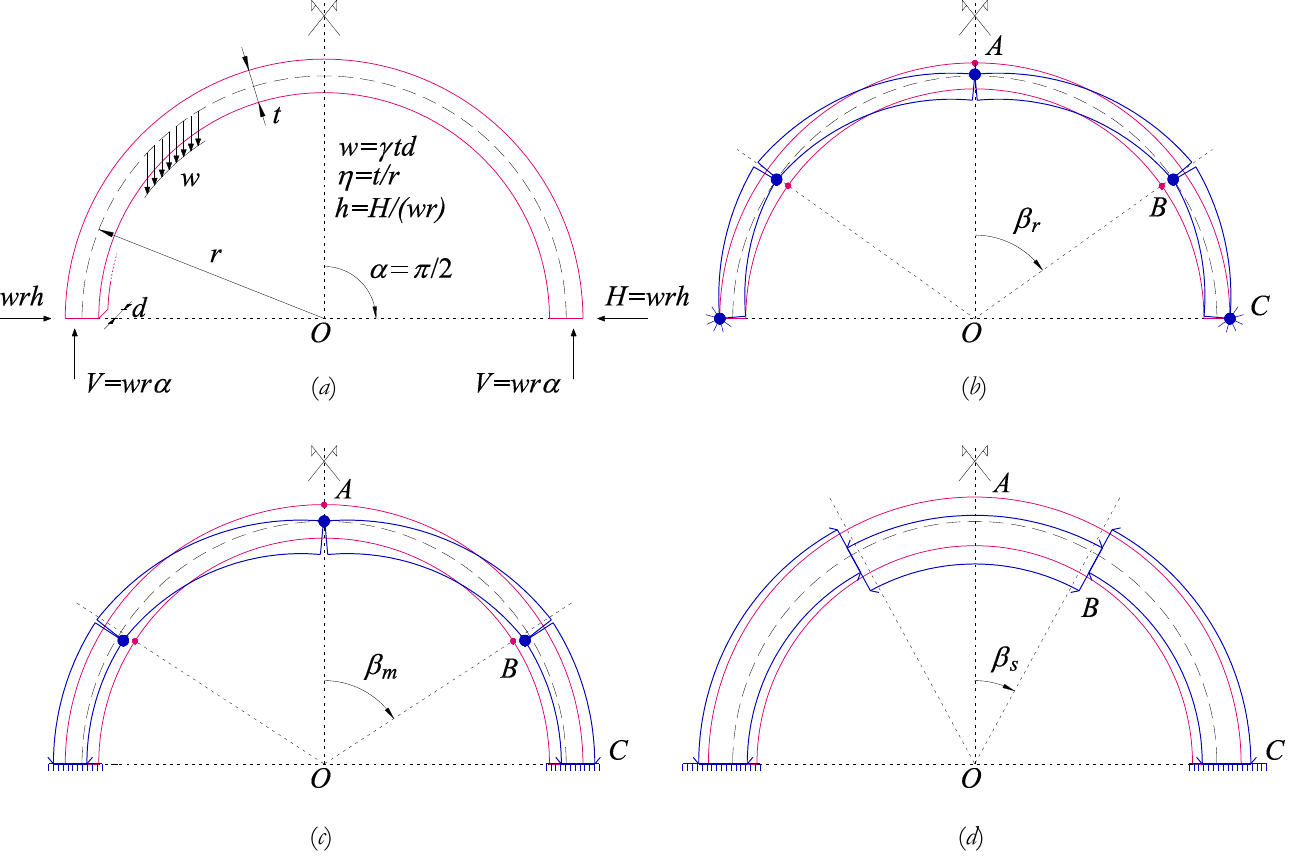
Figure 1: Sketches of a symmetric semi-circular masonry arch under self-weight: (a) characteristic parameters, primarily: half-angle of embrace  , inner rupture joint angular position  , thickness to radius ratio  , non-dimensional horizontal thrust h ; (b) purely- r otational collapse mode; (c) m ixed sliding-rotational collapse mode; (d) purely- s liding collapse